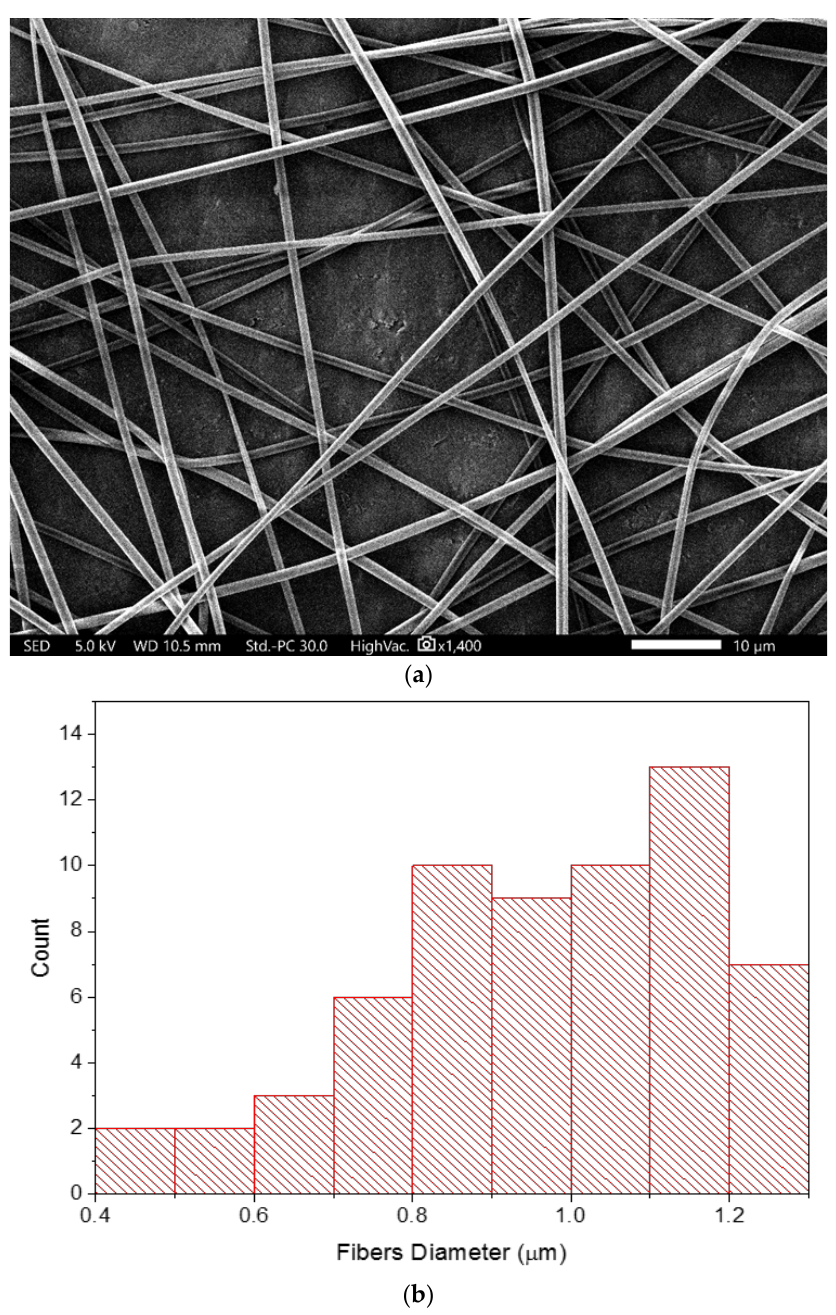
Figure 1. SEM image ( a ) and fibers diameter distribution ( b ) of the drug-loaded core–shell nanofibers, showing smooth, non-beaded, and non-porous surfaces of the fibers, with an average diameter of 968 ± 198 nm.